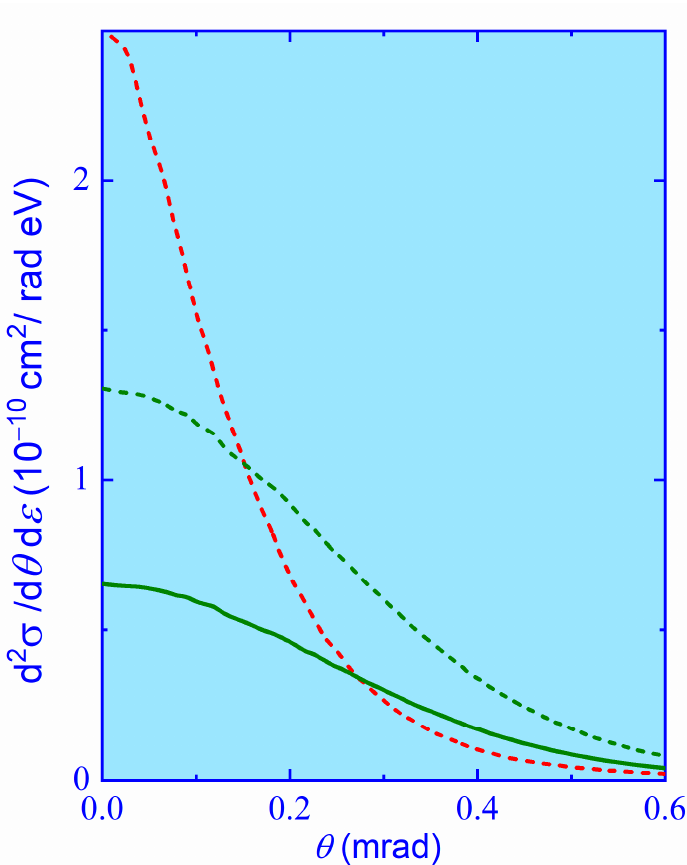
Figure 2. Doubly differential cross section for the ionization of H 2 by the impact of 75 keV protons as a function of the scattering angle θ and the energy loss ε of the projectiles. The energy loss is 30 eV. The theoretical [10] results are compared, for L = 50 cm (dashed red line) and 6.5 cm, with (solid green line) and without (dashed green line) the atomic concealment effect. In both cases, D = 0.15 mm. Note that the logarithmic scale of the vertical axis in Figure 1 has been changed to a linear one.